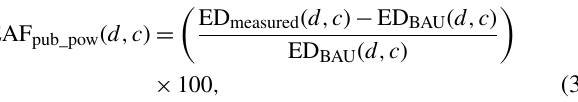
Animal numbers (cattle, swine, sheep, other) 6 Utilized agriculture area